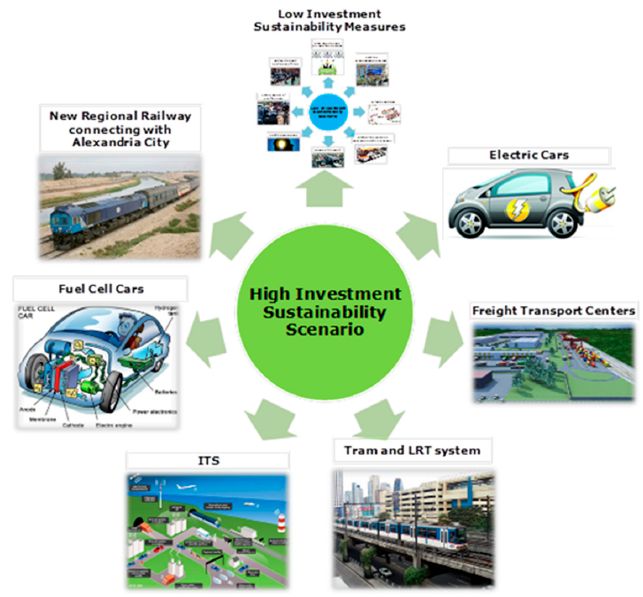
Figure 8. General description of the HIS scenario [27].